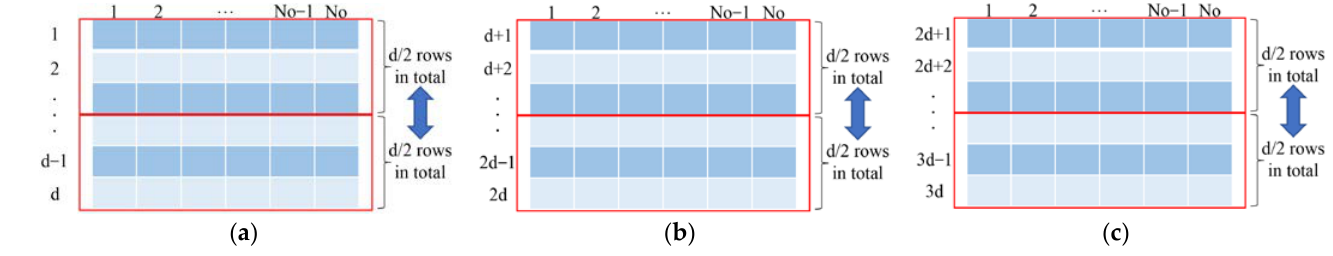
; ( b ) rows to ; 𝑟𝑟 𝑟𝑟 + 1 2 𝑟𝑟